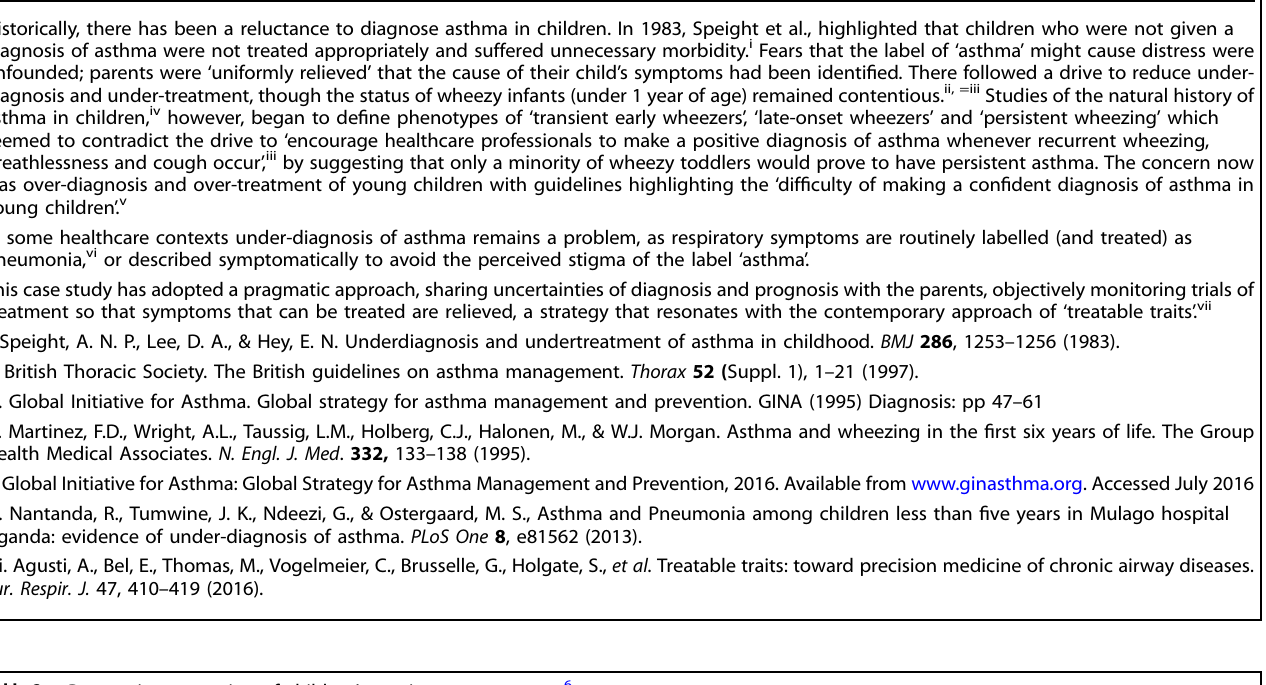
Table 2. Parents interpretation of children ’ s respiratory symptoms.